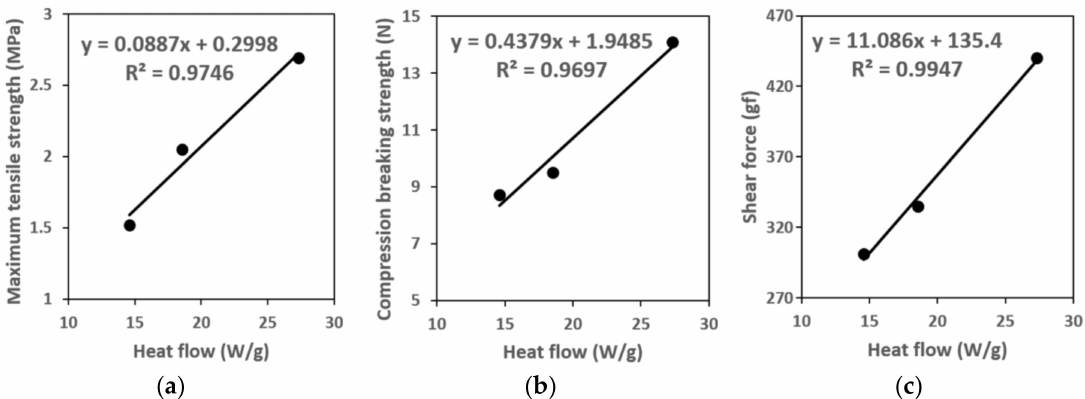
Figure 6. Results of mechanical tests: ( a ) relationship between curing reaction heat and ultimate tensile strength; ( b ) comparison of total heat of cure reaction and compression breaking strength of phosphor film per resin; and ( c ) comparison of total heat of cure reaction and shear force of phosphor film per